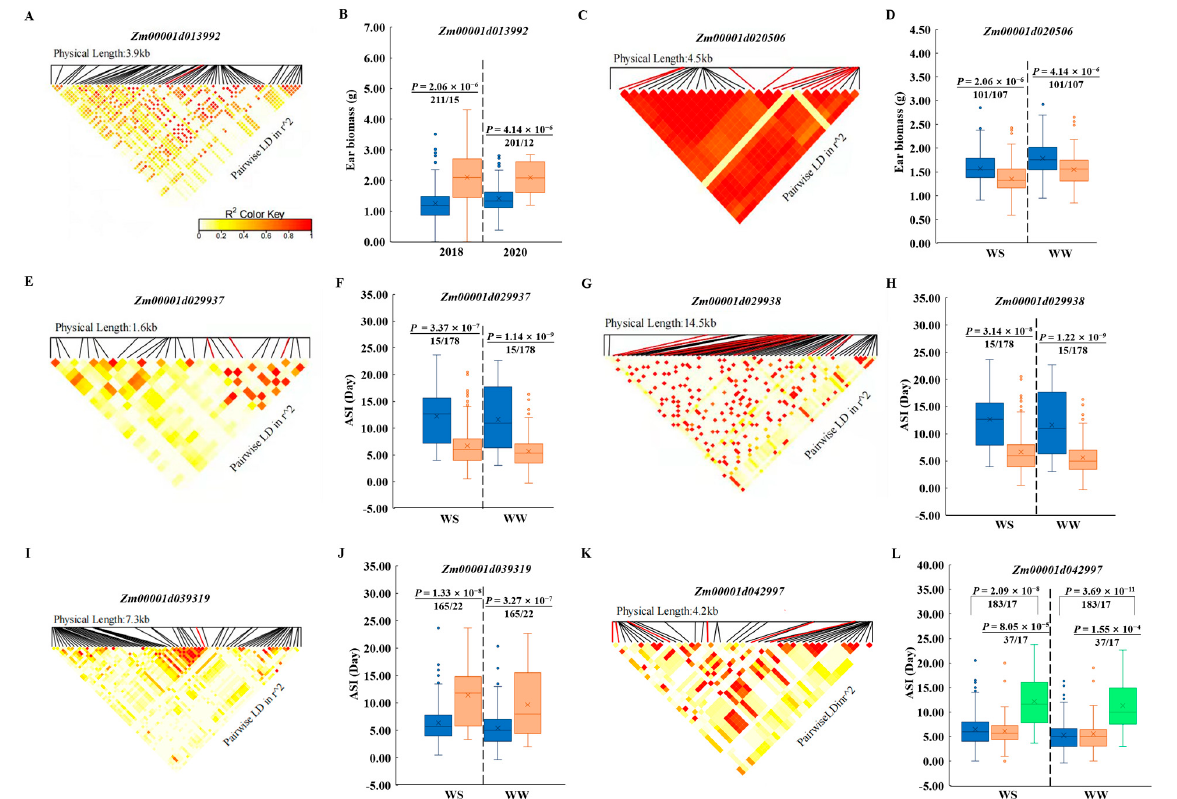
Figure 7. LD patterns and the allele effects of the most significant SNPs for candidate genes Zm00001d013992 ( A ), Zm00001d020506 ( C ), Zm00001d029937 ( E ), Zm00001d029938 ( G ), Zm00001d039319 ( I ), and Zm00001d042997 ( K ). Results of haplotype analysis for Zm00001d013992 ( B ), Zm00001d020506 ( D ), Zm00001d029937 ( F ), Zm00001d029938 ( H ), Zm00001d039319 ( J ), and Zm00001d042997 ( L ). Blue: HapA ; pink: HapB ; green: HapC